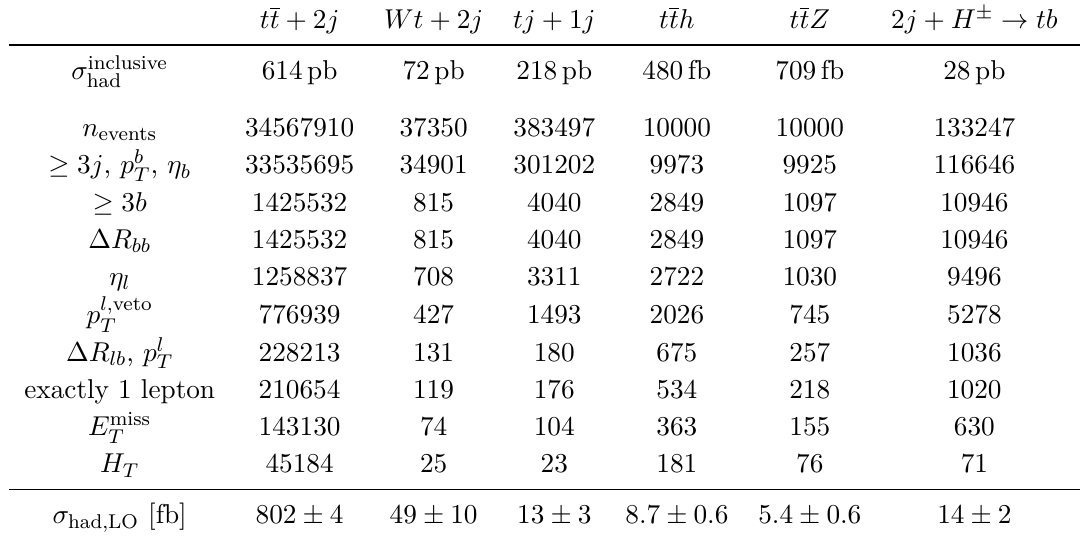
Table 2 . Cutflow of leading order partonic cross sections after merging in the